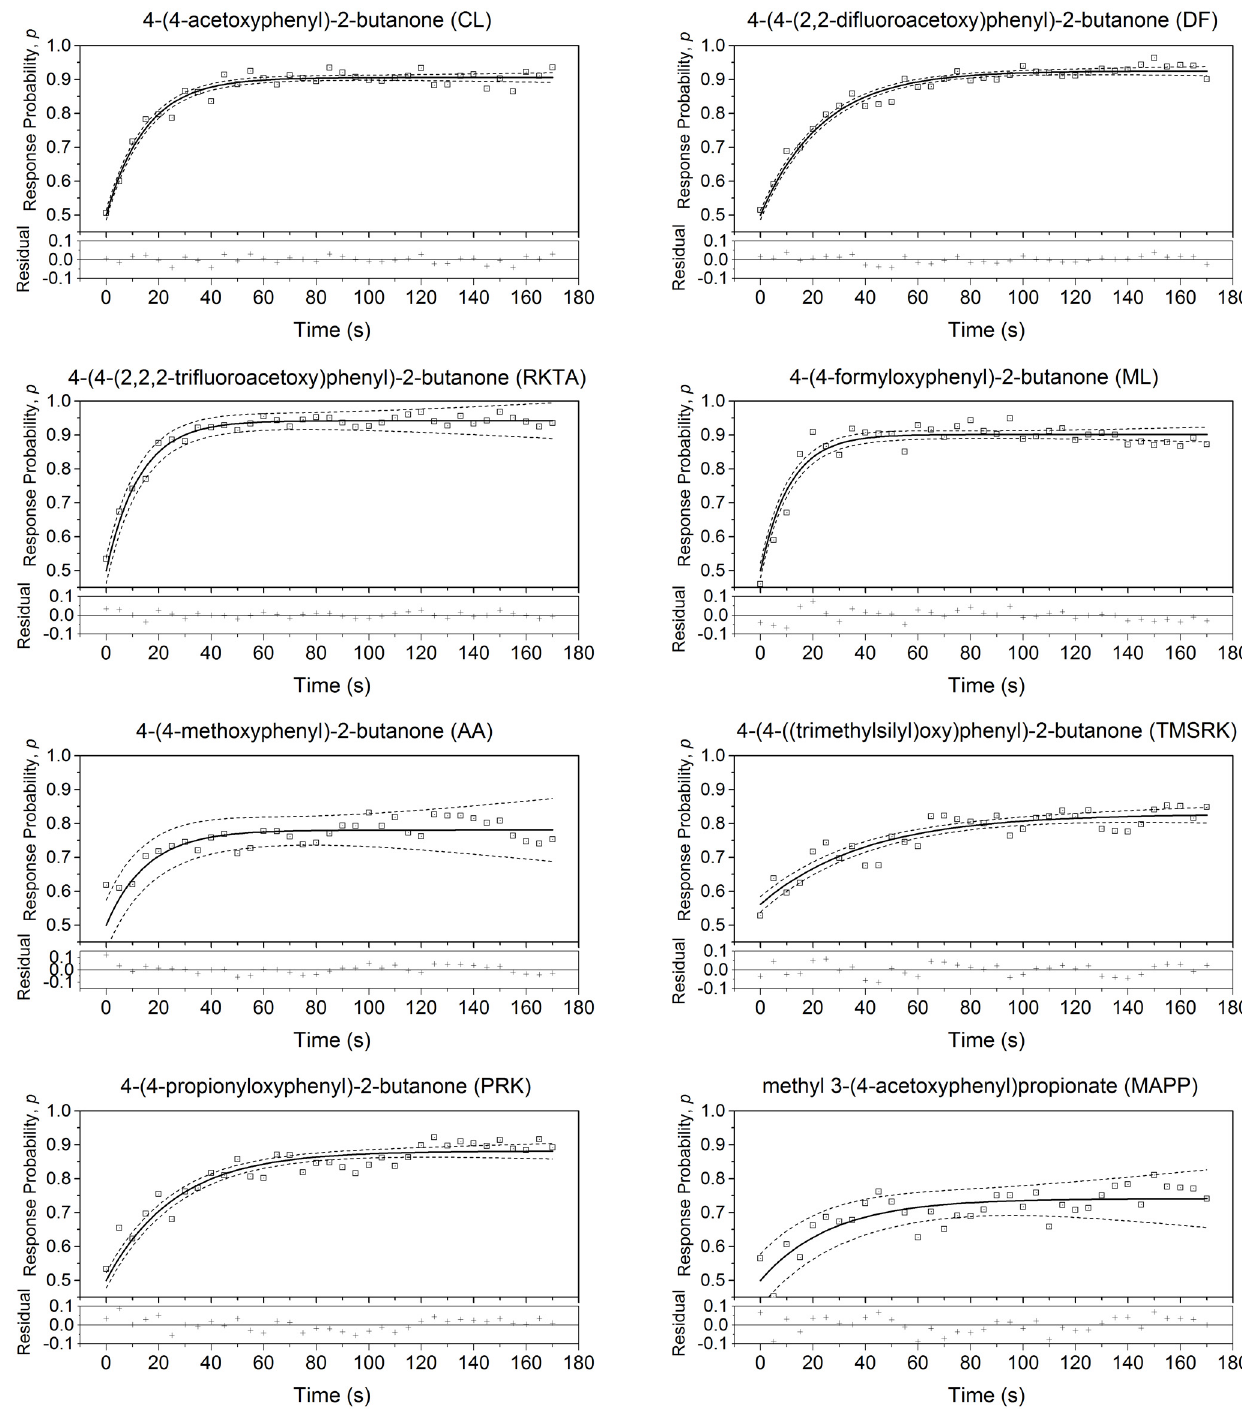
Fig 3. Fly Response Probabilities over Time. The response of flies to eight lures were measured over 170 seconds. An exponential function was fitted. Plots of the residuals are given.